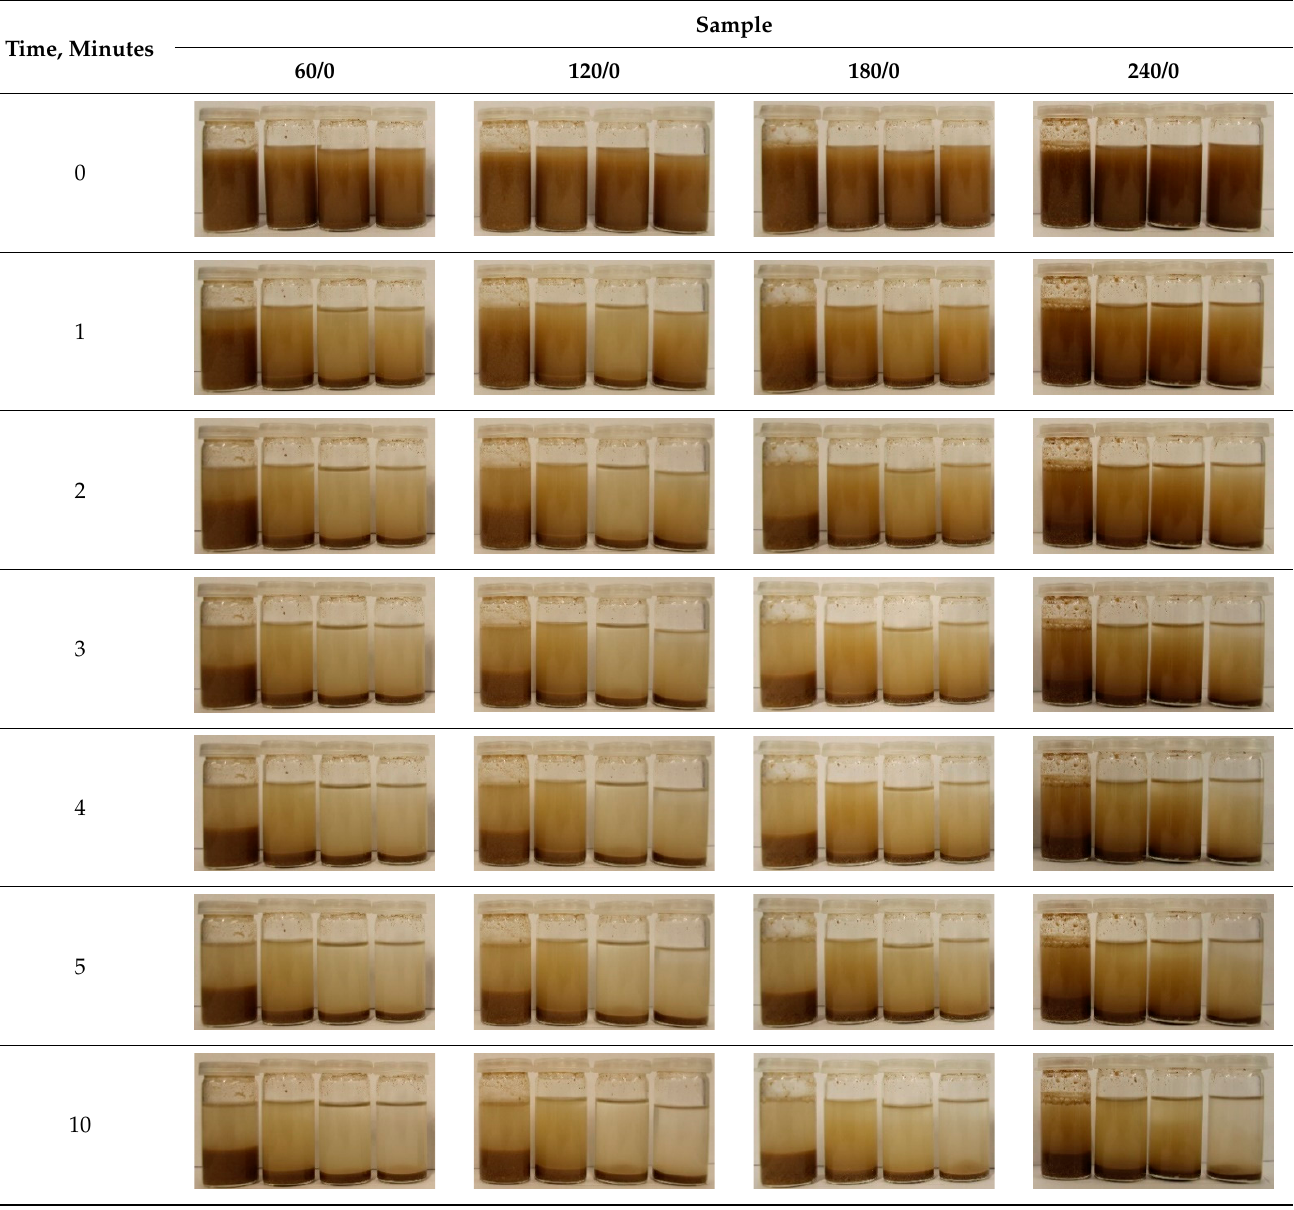
Table 2. The influence of treatment temperature on BSG behavior in particular solvents (from left to right—water, methanol, acetone, n -pentane).